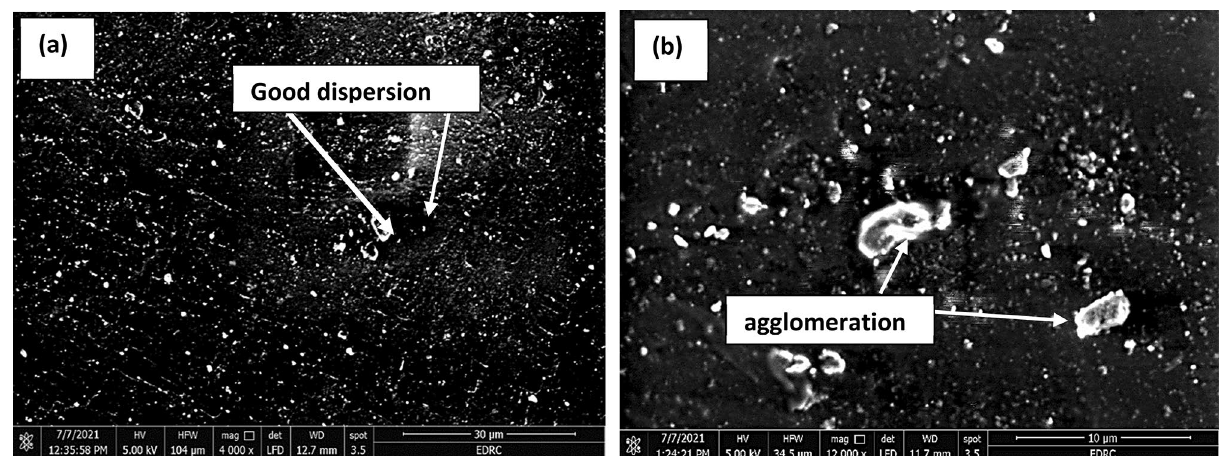
Figure 10. SEM showing the dispersion of alumina nanoparticles in ( a ) N1 and ( b )